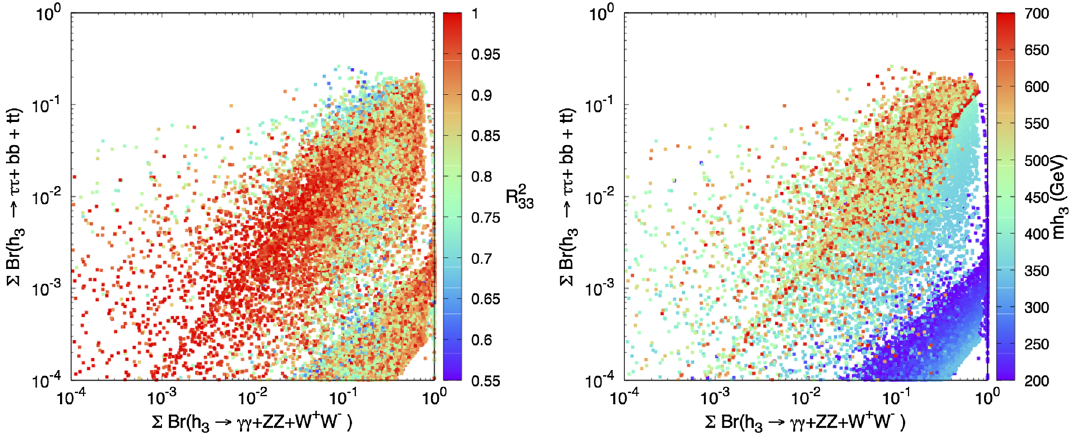
Fig. 10 Correlation between Br ( h 3 → f f ) and Br ( h 3 → V V ) versus R 2